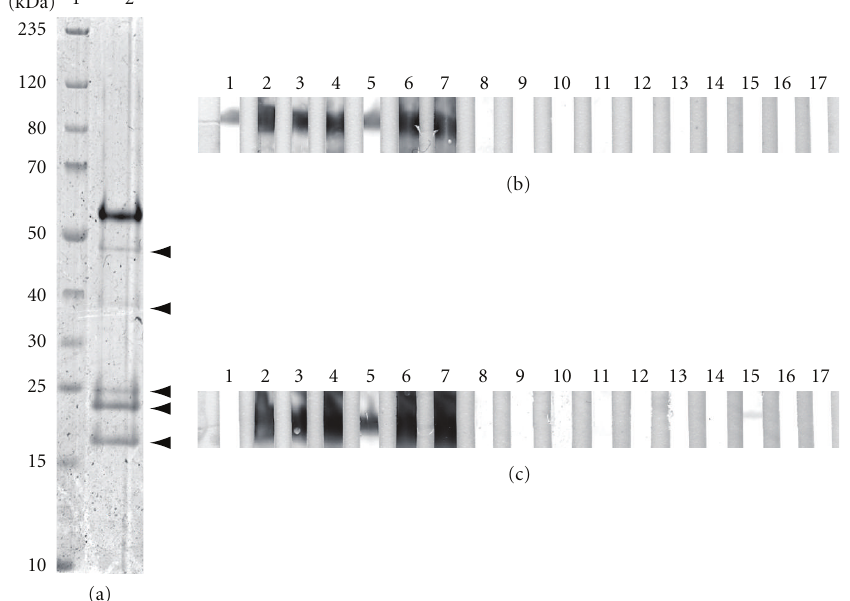
F 1: Characterization of recombinant SLA proteins by SDS-PAGE and westernblot. (a) Bacterially expressed SLA was analyzed by SDS-PAGE with coomassie staining. Lane 1: molecular mass markers, kDa indicated; lane 2: 2 the presence of anti-His-�ag antibody reactive SLA-fragments veri�ed by mass spectrometry, (b) 1 E. coli, (c) or cell-free supernatant from HEK293 expressing SLA; lane 1: murine monoclonal antibody against hexahistidine; lanes 2: rabbit polyclonalserumagainstSLA;lanes3–7:anti-SLApositiveserafrompatientswithautoimmunehepatitis(AIH);lanes8–12:anti-SLAnegative sera from patients with AIH; lanes 13–17: sera from healthy blood donors; the band in c, lane 15 does not correspond to SLA.